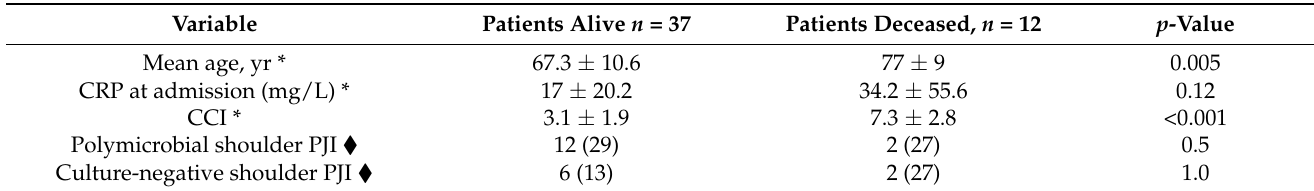
Table 3. Demographic data, clinical, and laboratory findings of the alive and deceased